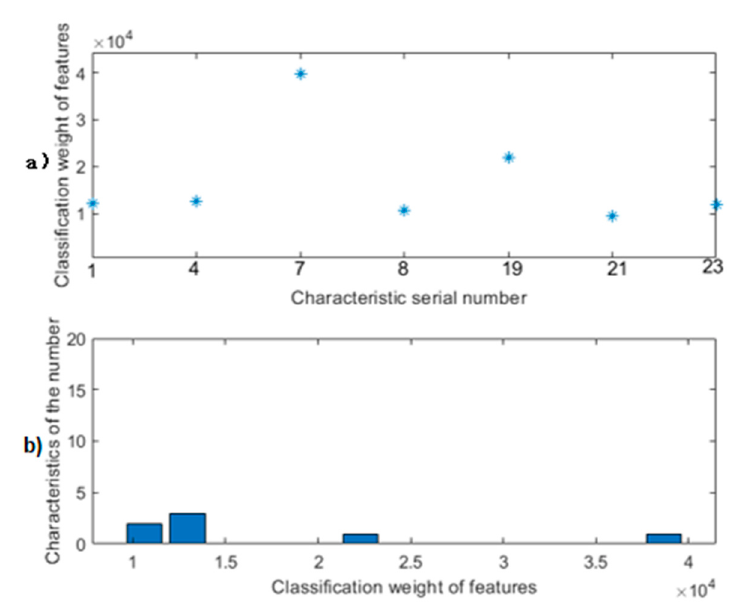
Figure 4. Feature classification weight diagram before threshold setting: ( a ) Upper submap: Feature weight value map; ( b ) Lower submap: Weight value frequency chart.